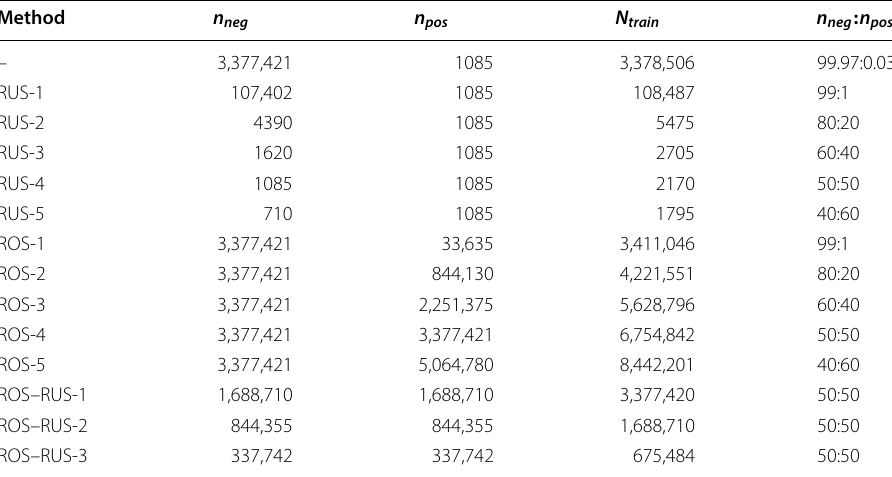
Table 7 Varying levels of class imbalance with ROS and RUS Method n neg n pos N